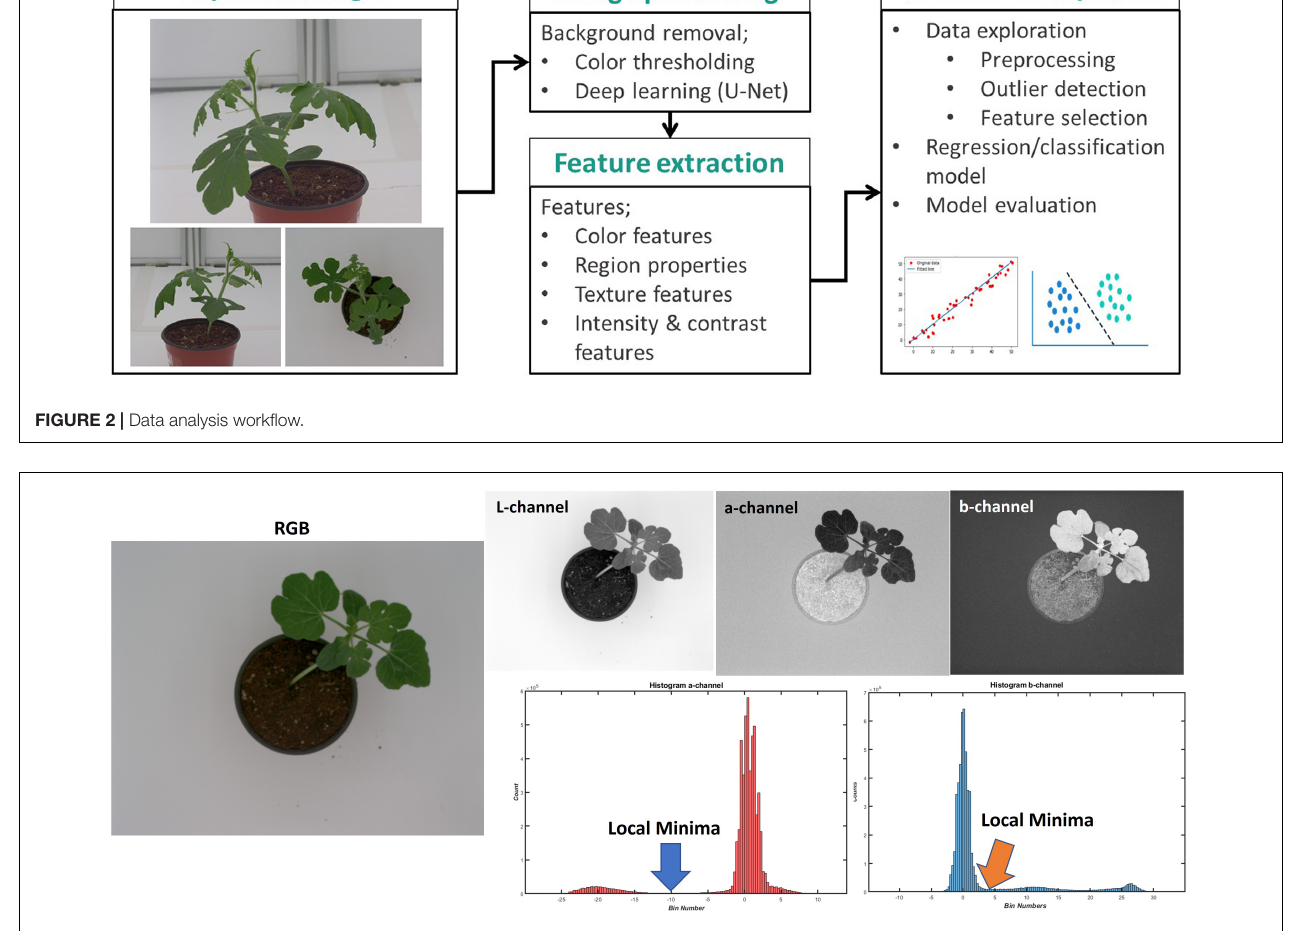
FIGURE 3 | Summary of conventional image processing background removal